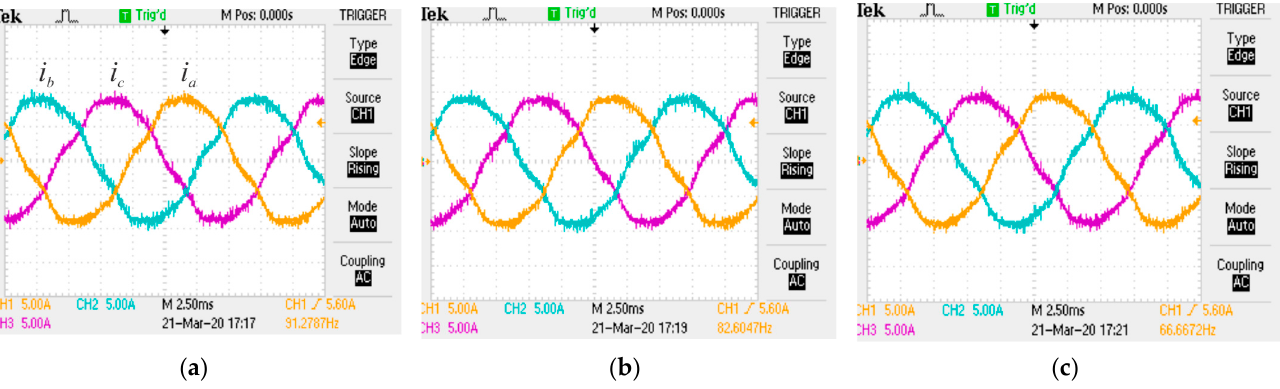
Figure 8. Transient analysis of current control, without feedforward compensation. ( a ) abc–PR, ( b ) αβ –PR, and ( c ) dq ‐ PI.